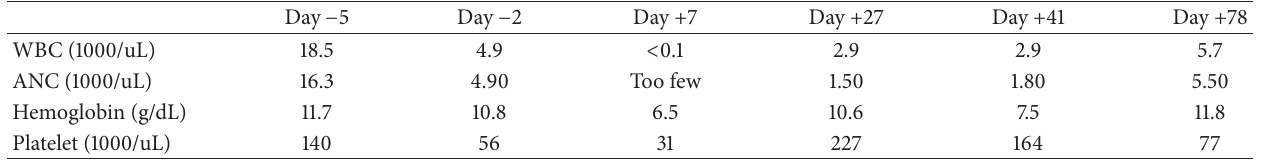
Table 1: Laboratory results before and after allogeneic